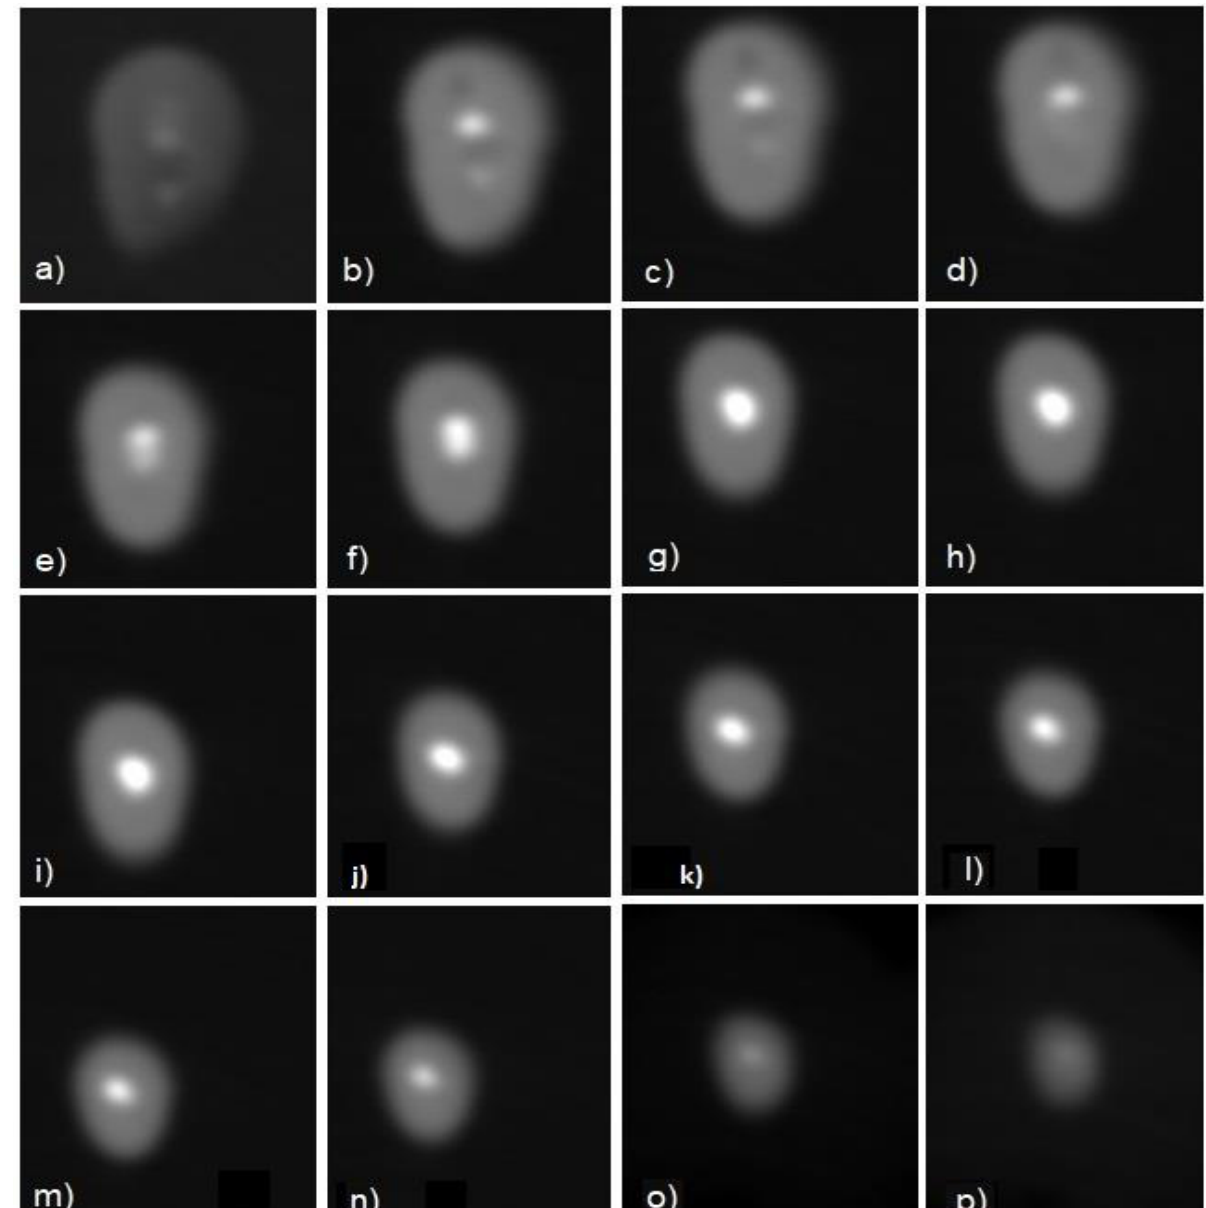
Figure 1. Axial CBCT acquisitions (0.125 mm thickness) of middle ( a – h ) and apical third ( i – p ). The presence of two Gutta-percha cones is appreciable at the beginning of the middle third ( a – d ). Apically, the presence of a single cone can be assessed by a decrescent radiodensity, barely visible at the end of the root ( p ). Boundaries between the Gutta-percha cone and the dental tissue are blurry due to scattering which cannot allow the operator to clearly define the presence of voids.